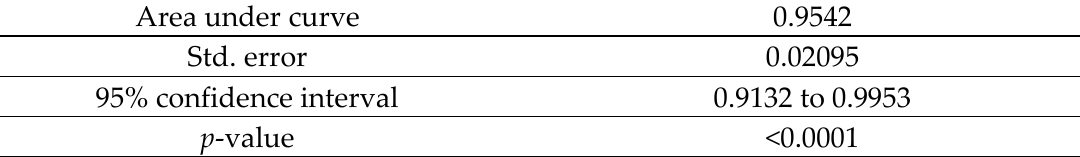
Figure7. ROC curve for HBME-1 (2008 and 2013). Figure 7. ROC curve for HBME-1 (2008 and 2013).